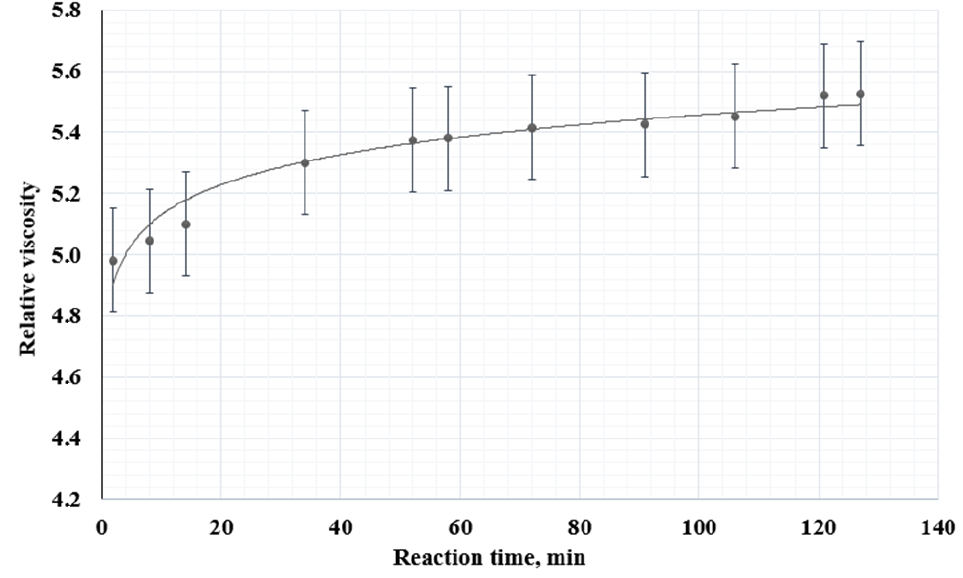
Table 2. Weight losses of the composites and the initial β -TCP depending on the duration of sample soaking in the physiological solution.